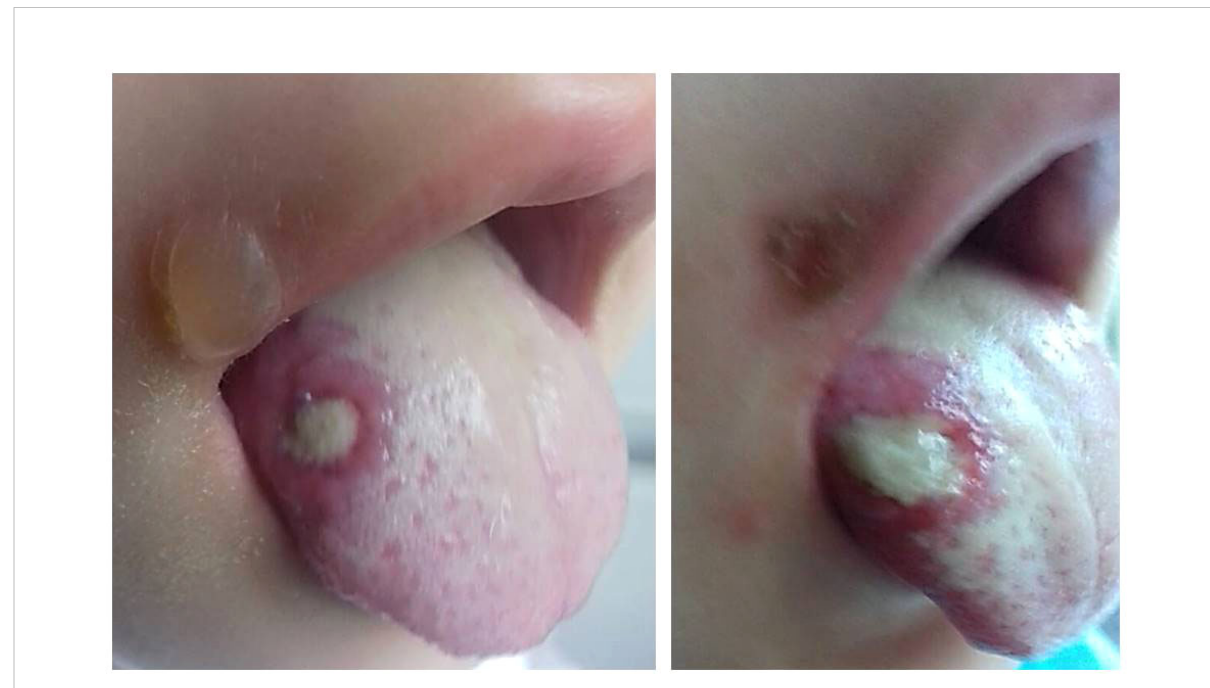
FIGURE 1 Deep ulcer on the right side of the tongue. Bullous lesion near the edge of the mouth is also visible. The pictures were taken three days